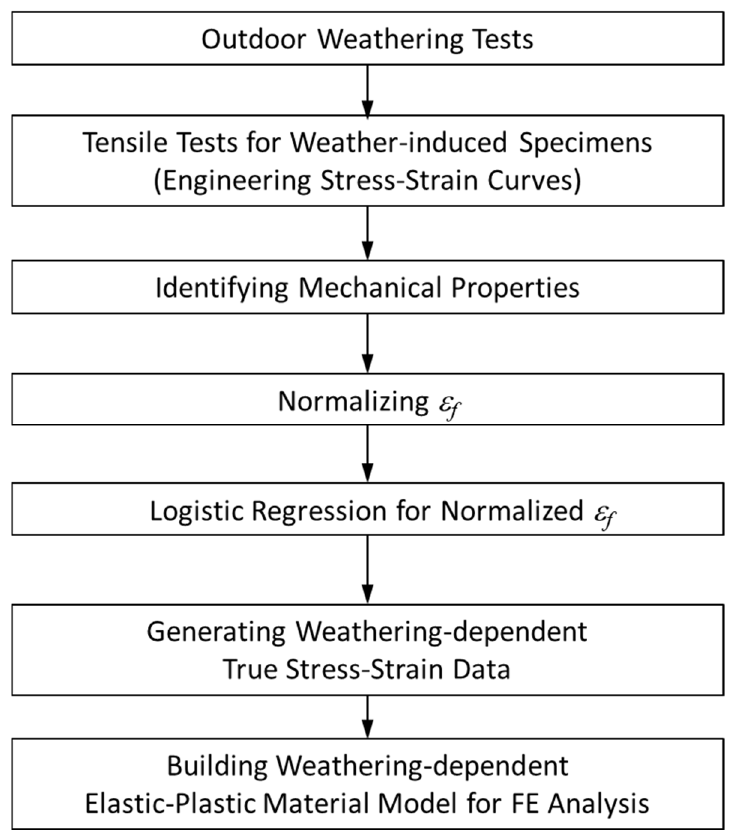
Figure 17. Flowchart of building weather-affected material data for structural FE Analysis.